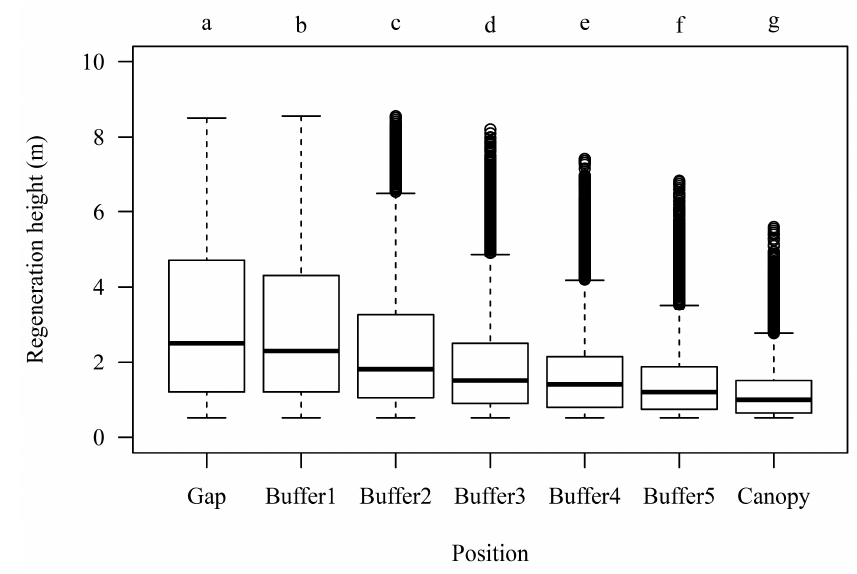
Figure 6. Box–whisker plots of the regeneration vegetation height (m) in dependence of position in gap, in buffer zone (1–5 m) or under closed canopy. Different lower-case letters indicate significant differences between positions at the level of p < 0.05.